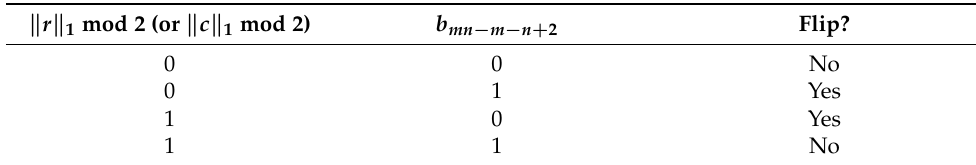
Table 1. The condition to flip all the bits in the parity pair ( r , c ) for encoding a message to an odd-by-odd game, where m , n ≥